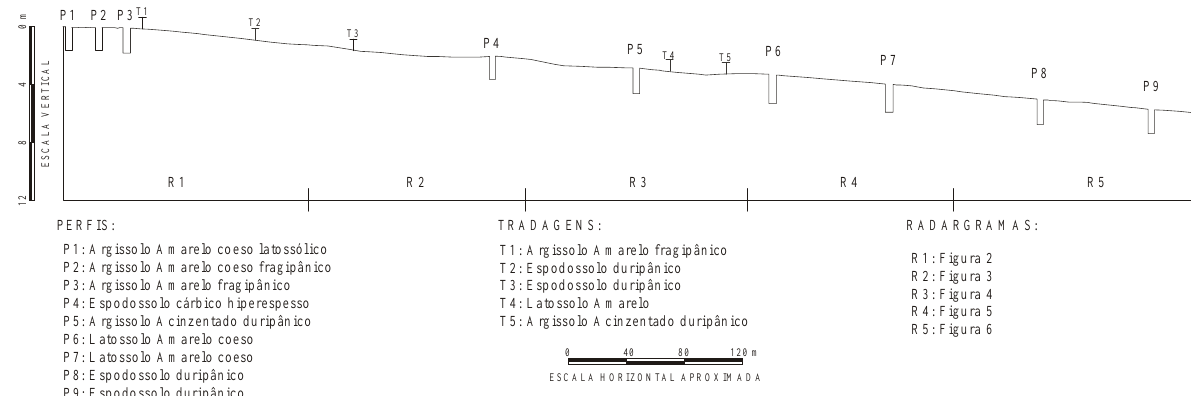
R1: Figura 2 R2: Figura 3 R3: Figura 4 R4: Figura 5 R5: Figura 6